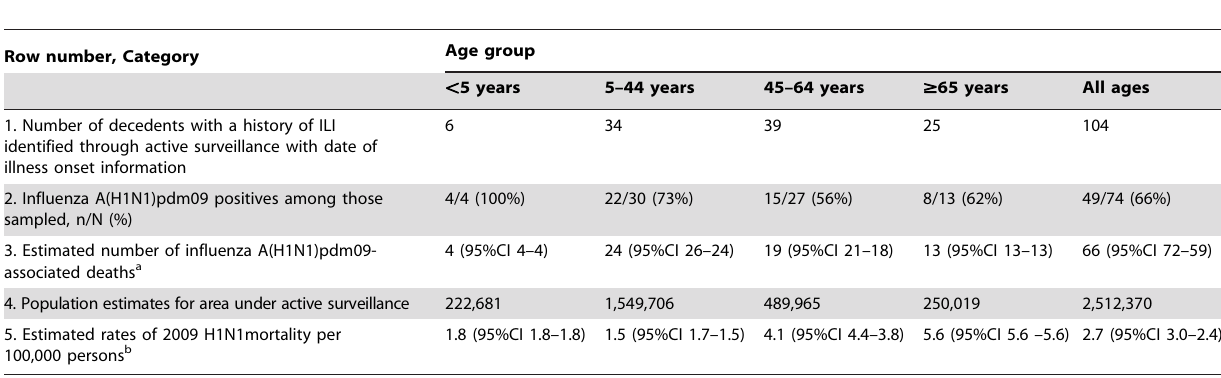
Table 1. Rates of influenza A(H1N1)pdm09-associated mortality among influenza-like illness (ILI) cases at three sentinel cities in Argentina, according to age group. April–December,